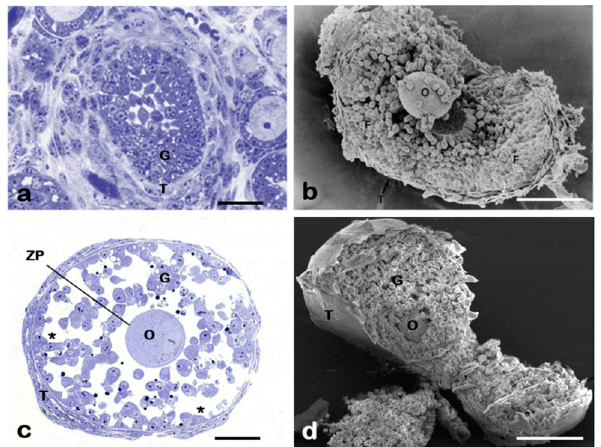
Figure 4. General appearance of in vivo ( a , b ) and in vitro grown (IVG) ( c , d ) mouse follicles, the latter cultured in a 2D system up to antral stage under: ( a , c ) light microscopy; and ( b , d ) scanning electron microscopy. ( a ) The oocyte is not visible due to the plan of section, which is not equatorial. Abbreviations: O (oocyte); ZP (zona pellucida); G (granulosa cells); T (theca cells); asterisks: fluid-filled spaces (antrum). Bar = 50 µm ( a , c ); 100 µm ( b , d ). Modified from: Macchiarelli et al. (1992) [43] ( b ) and Nottola et al. (2011) [30] ( c , d ), with permission.